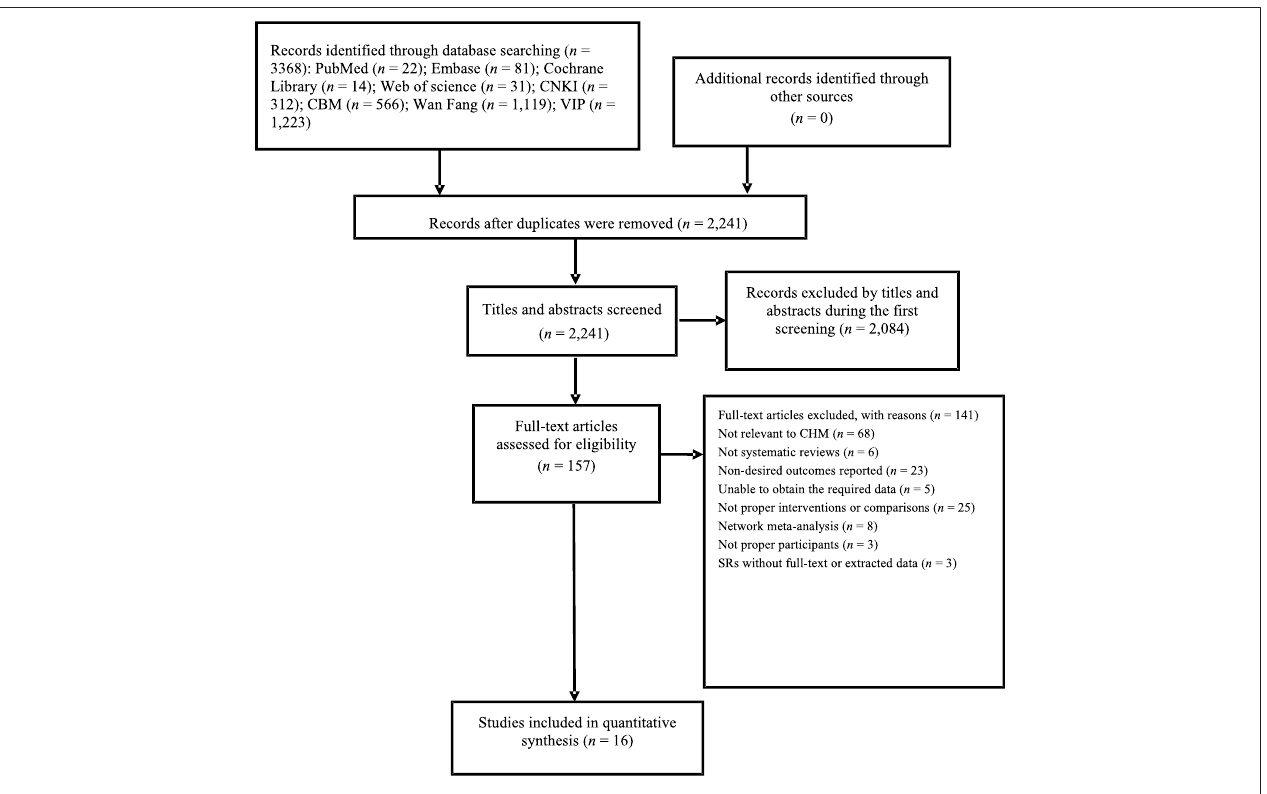
FIGURE 1 | Flow diagram of the study